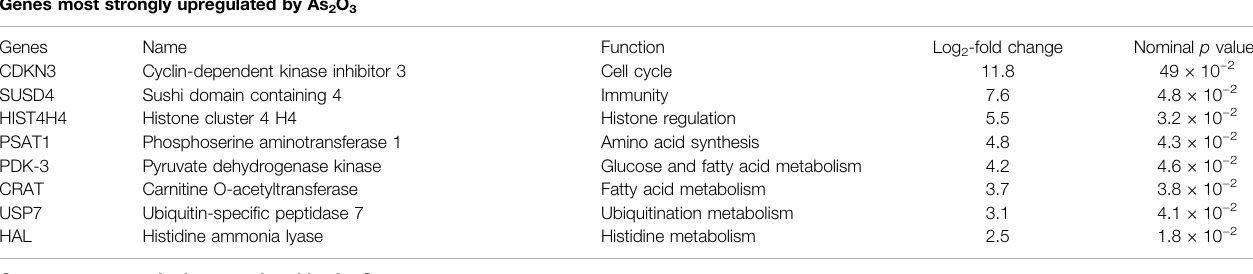
TABLE 3 | Eight most strongly up- and downregulated genes in As 2 O 3 -treated RA Treg cells relative to control. Genes most strongly upregulated by As 2 O 3